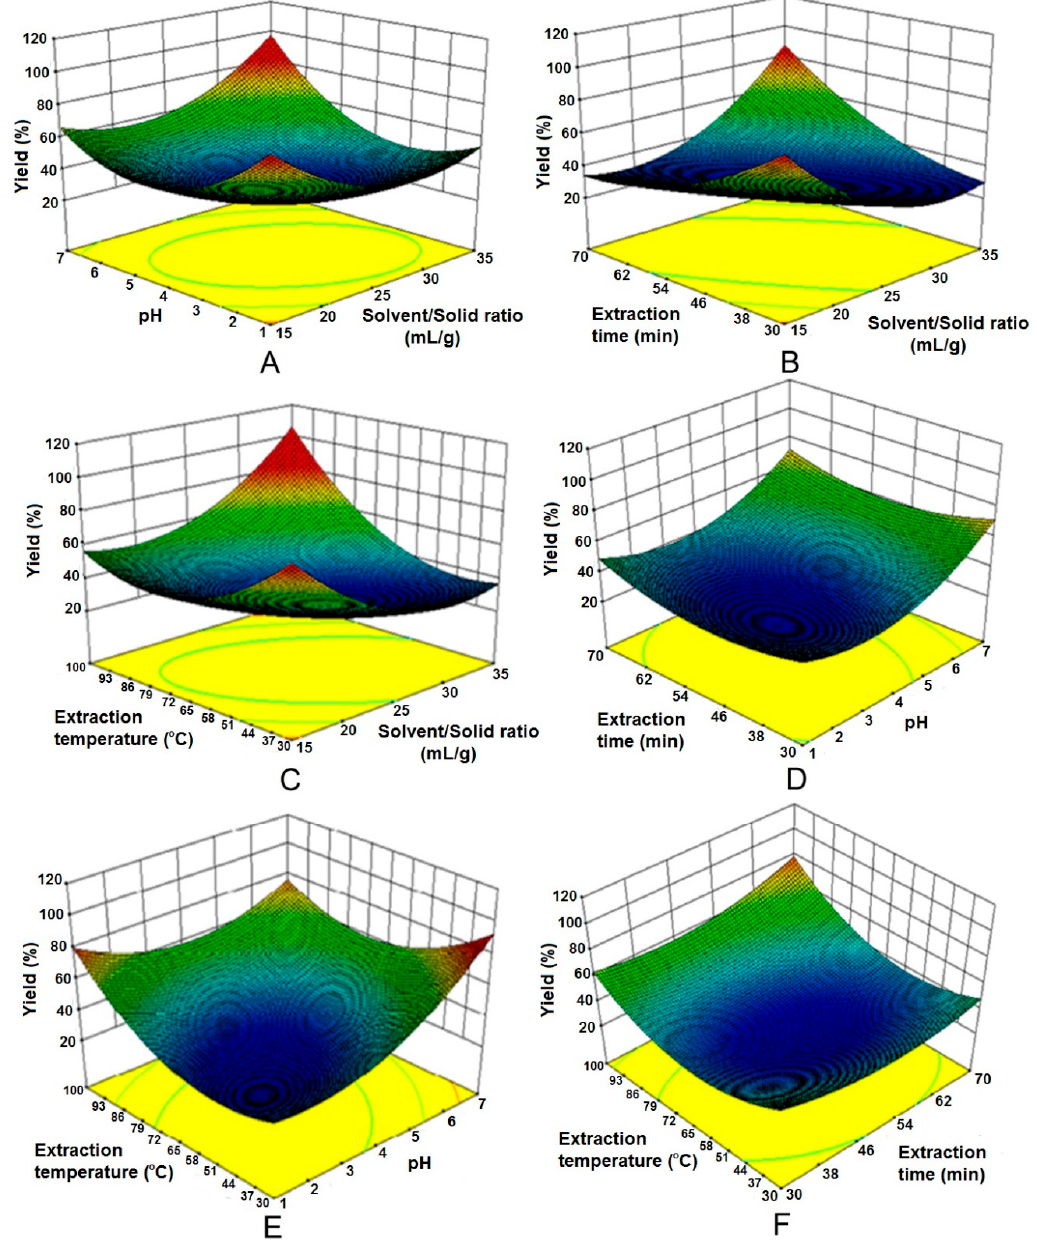
Figure 11. Response surface plot shows the individual and synergistic effects of ( A ) pH and solvent/solid ratio (mL/g); ( B ) extraction time (min) and solvent/solid ratio (mL/g); ( C ) extraction temperature (°C) and solvent/solid ratio (mL/g); ( D ) extraction time (min) and pH; ( E ) extraction temperature (°C) and pH; and ( F ) extraction temperature (°C) and extraction time (min) on the boric acid extraction yield (%).